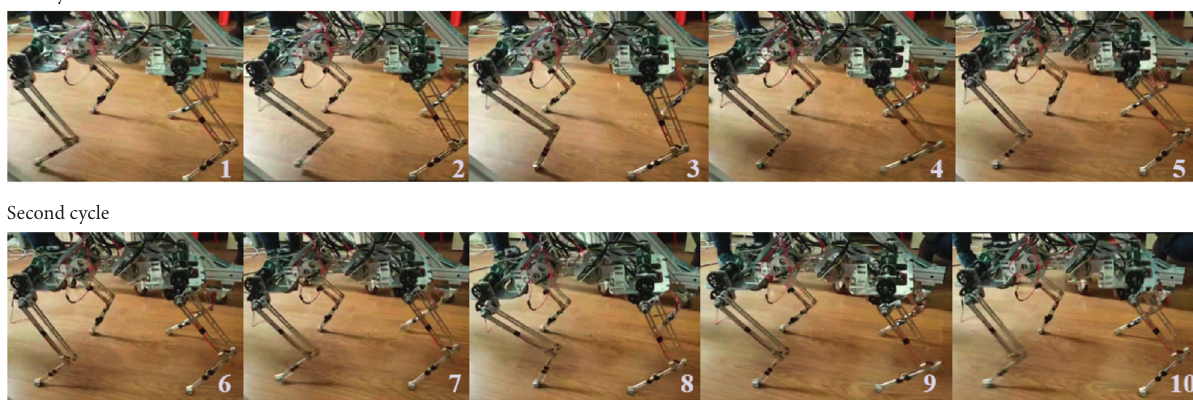
Figure 12: Trotting motion of the quadruped robot.